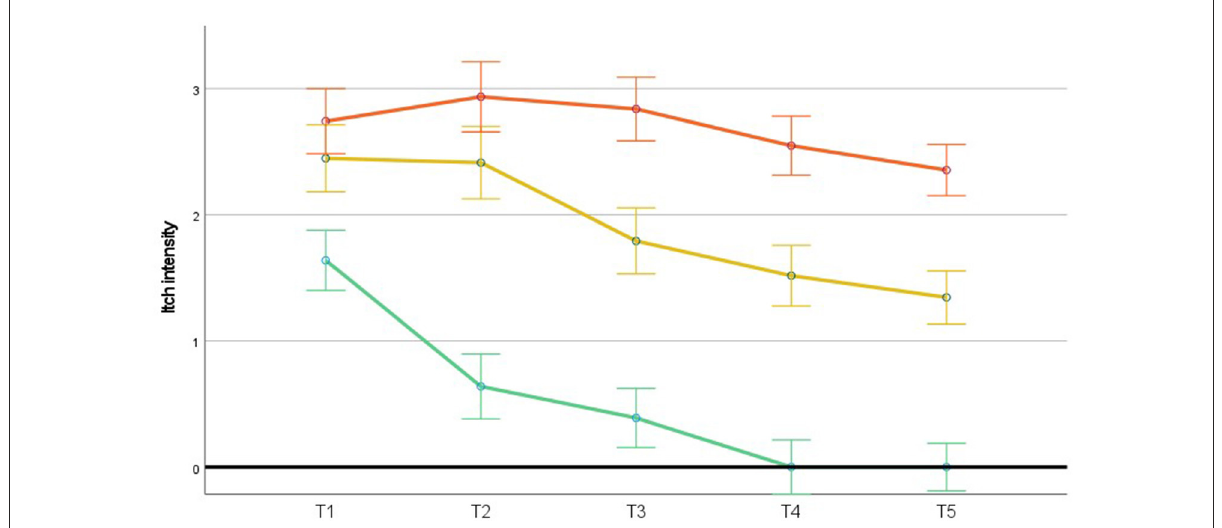
FIGURE2 Time course of estimated means of itch intensity (ranging from 0 to 6) in the three itch profiles. N = 96 (full cases). Upper line (orange) = chronic itch & pain ( n = 31), middle line (yellow) = chronic itch ( n = 29), lower line (green) = transient itch/pain ( n = 36). Error bars represent 1 standard deviation. T1 = 2 weeks post-discharge, T2 = 3 months post-burn, T3 = 6 months post-burn, T4 = 12 months post-burn and T5 = 18 months